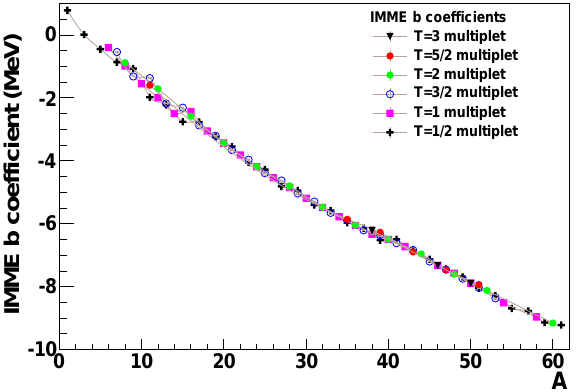
Figure 2. b coe ffi cients, in MeV, shown as a function of atomic mass number A extracted from a second degree IMME polynomial fit: a + bT z + cT 2 . This coe ffi cient is interpreted as being directly related to the vector part of z the Coulomb force b = ∆ nH + E (1) . C